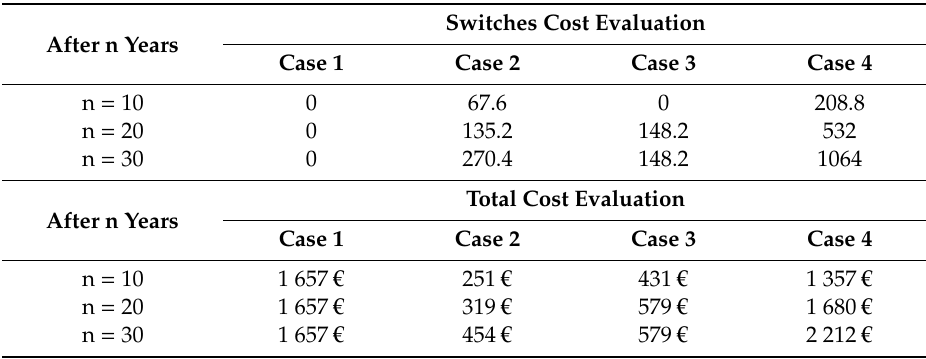
Table 7. Cost evaluation according to the estimated endurability, as reported in Table 6 in the four cases, for the “worst case” condition.